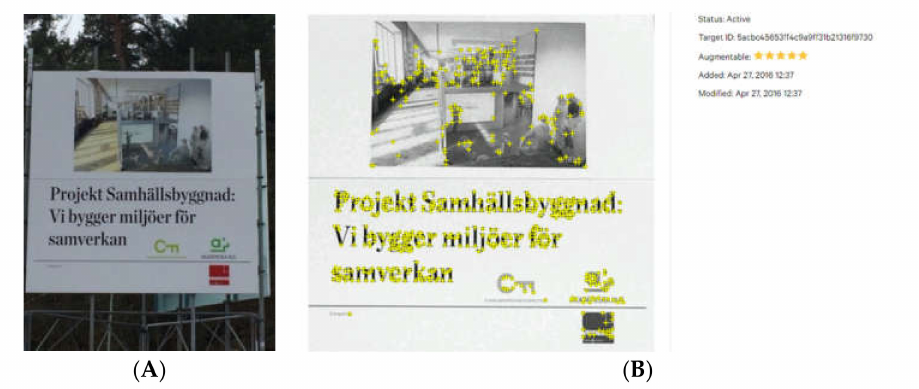
Figure 3. Display placard ( A ) used for P5, ( B ) shows the Vuforia’s rating for recognizability of the placard as a tracker based on the patterns in the